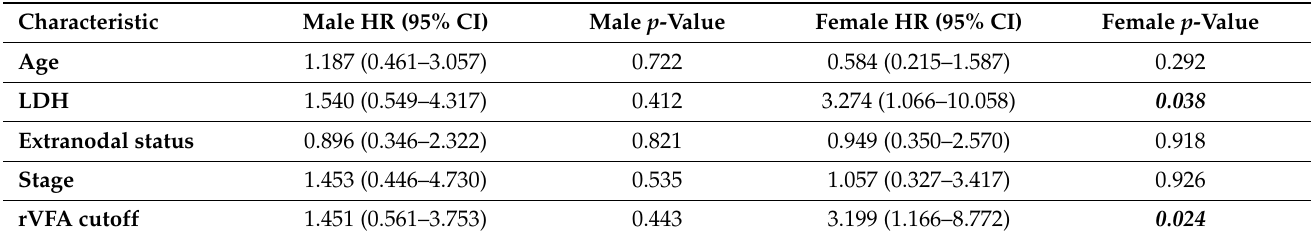
Table 4. Progression-Free Survival (PFS) multivariate Cox regression analysis for